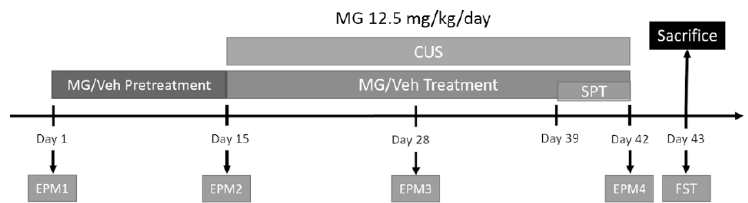
Figure 5. Schedule for malvidin-3- O -glucoside (MG) treatment and chronic unpredictable stress (CUS) protocol. CUS was subjected to the mice for 28 days, consisting of a plethora of different stressors, and the effect of MG on the resulting stress-induced anxiety was evaluated using the elevated plus maze (EPM). To monitor anxiety progress, this assay was performed at four time points throughout the experiment: EMP1: before MG pre-treatment, EPM2: one day before starting CUS, EPM3: 15 days after starting CUS, and EPM4: one day after finishing CUS.